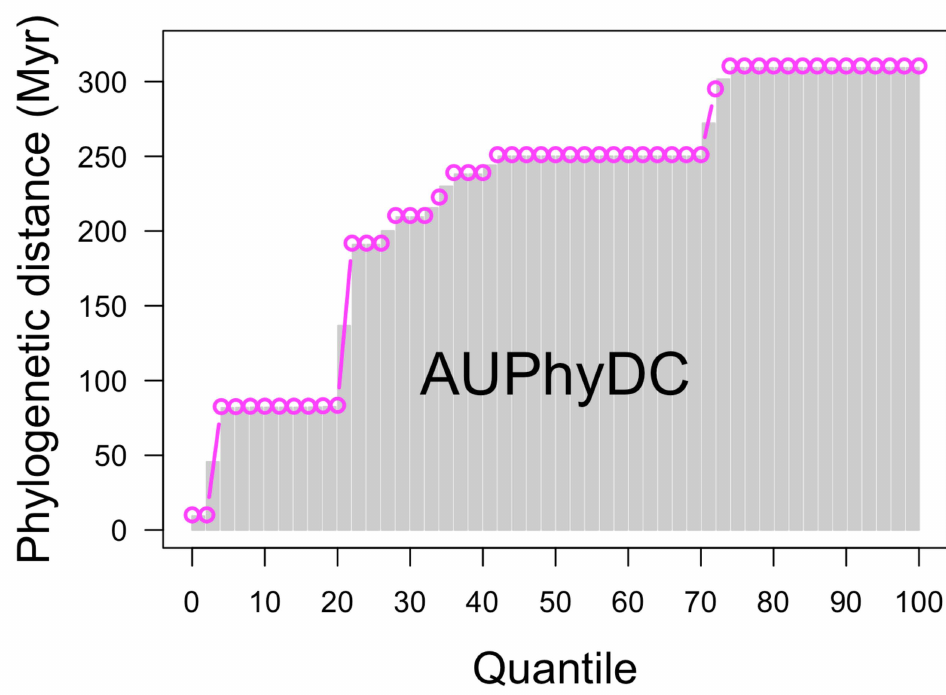
Figure 5. Area under the phylogenetic distance curve (AUPhyDC). The AUPhyDC provides a flexible, integrative measure of the overall distribution of phylogenetic distances from a focal taxon to all the other taxa in its community. The magenta line and circles show the cumulative phylogenetic distance curve of Cirsium vulgare , as shown in Figure 3. Each circle is the phylogenetic distance associated with that quantile, in increments of 2%. The area under that curve (AUPhyDC: area under the phylogenetic distance curve, in grey) can be estimated using a Reimann sum of the area of each of the grey rectangles (see Section 2.4 and File S1). The AUPhyDC is larger for taxa that are more evolutionarily isolated from their surrounding community because long phylogenetic distances are reached at lower